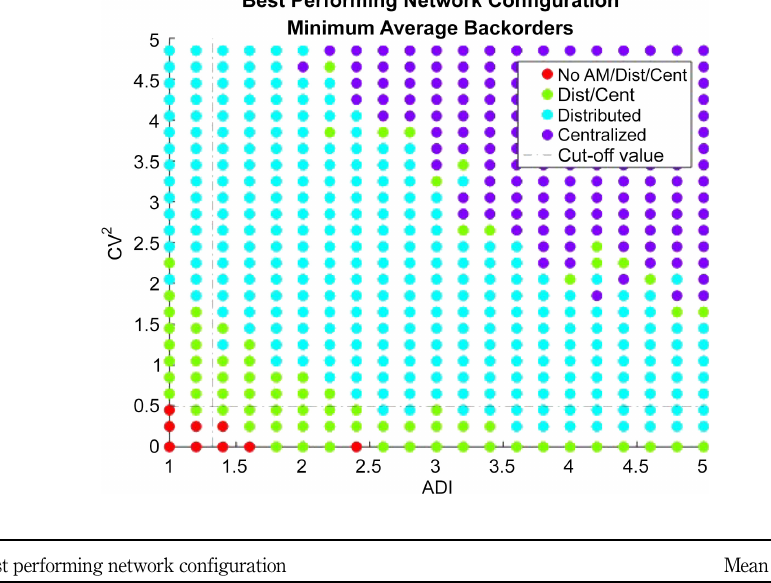
Table 3. Average percent gap for average backorders using decision boundaries applied to Figure